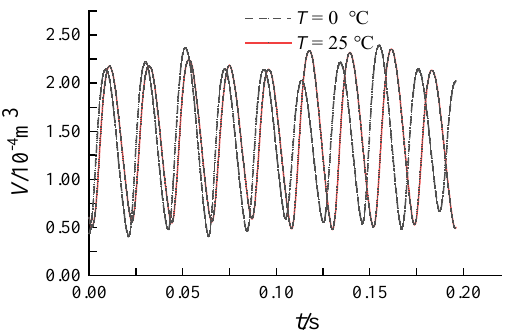
Figure 7. Comparison of natural cavity evolution between 0 °C and 25 °C cases.